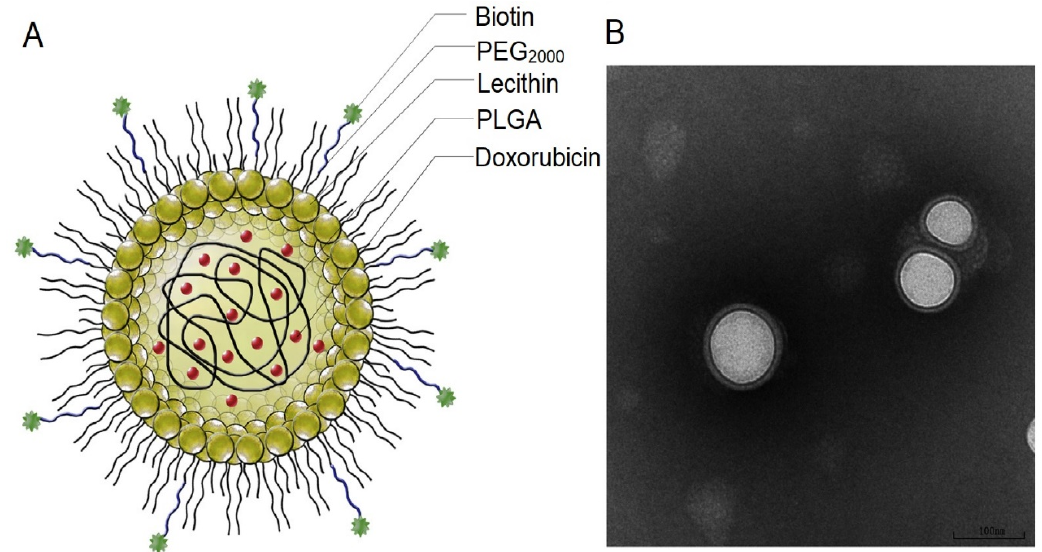
Figure 5. A schematic presentation ( A ) and TEM image at a scale = 100 nm ( B ) of DOX-PLGA-lecithin-PEG-biotin nanoparticles ( B ). With permission from Dai et al. [120].